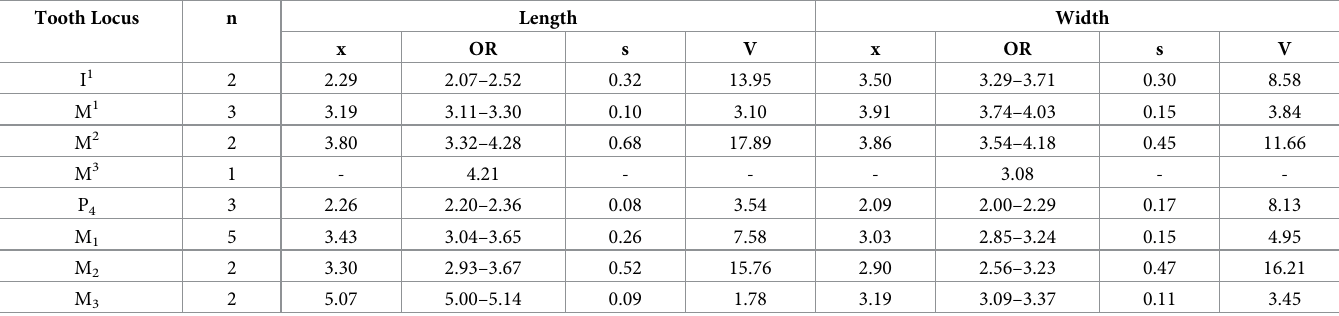
Table 2. Summary of dental measurements (in mm) for Ignacius dawsonae from Ellesmere Island, Nunavut, Canada. Tooth